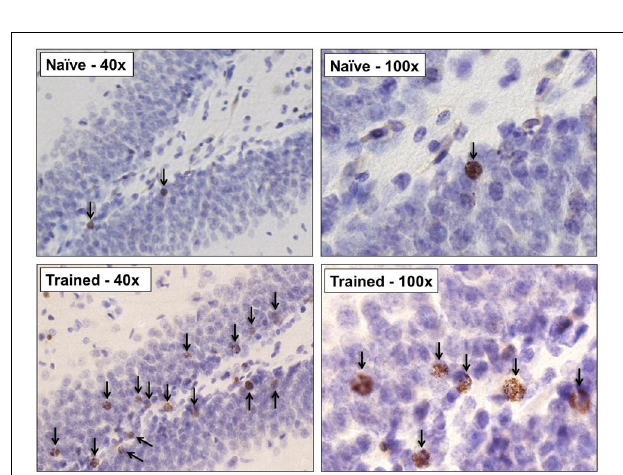
injection retained more cells than naive animals perfused three weeks after BrdU injection ( N = 10). This was observed in both the granule cell layer (GCL), and (C) the hilus. Asterisk indicates p ≤ 0 . 05.